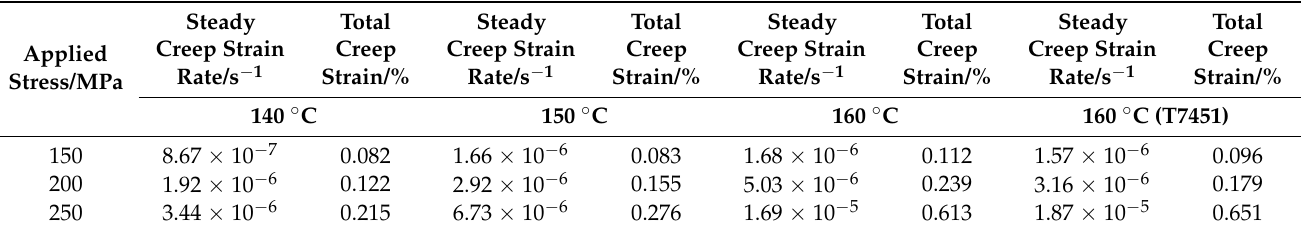
Table 1. Steady creep strain and total creep strain of 7B04-P and 7B04-T7451 aluminum alloy with different temperatures and applied stress.